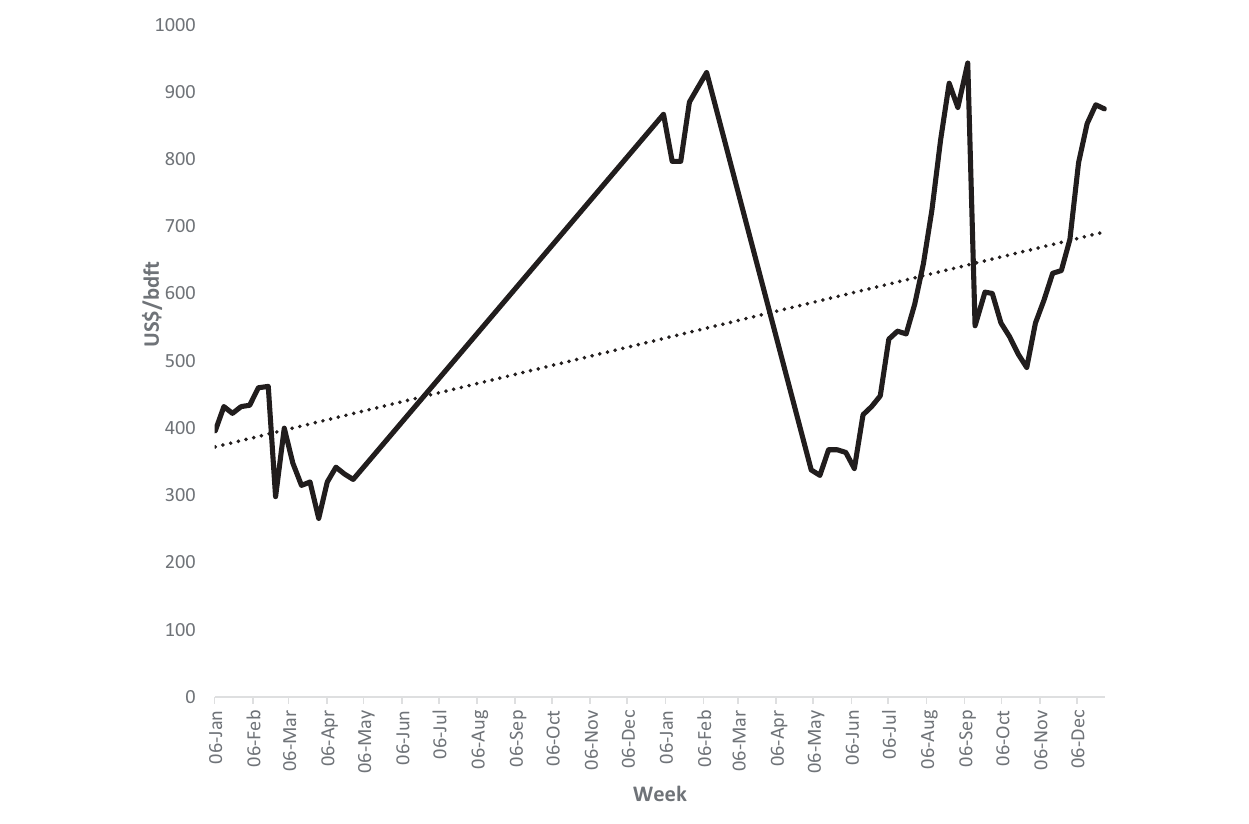
FIGURE 4 | Weekly average lumber prices (US$/board foot) in 2020, based on futures contracts traded on the Chicago Mercantile Exchange of lumber manufactured in the United States and Canada. The dotted line is the linear trend; prices initially dropped in March due to the COVID-19 pandemic, spiked in September to record highs, then dropped again and rebounded in November (Source: Trading Economics, 2021).